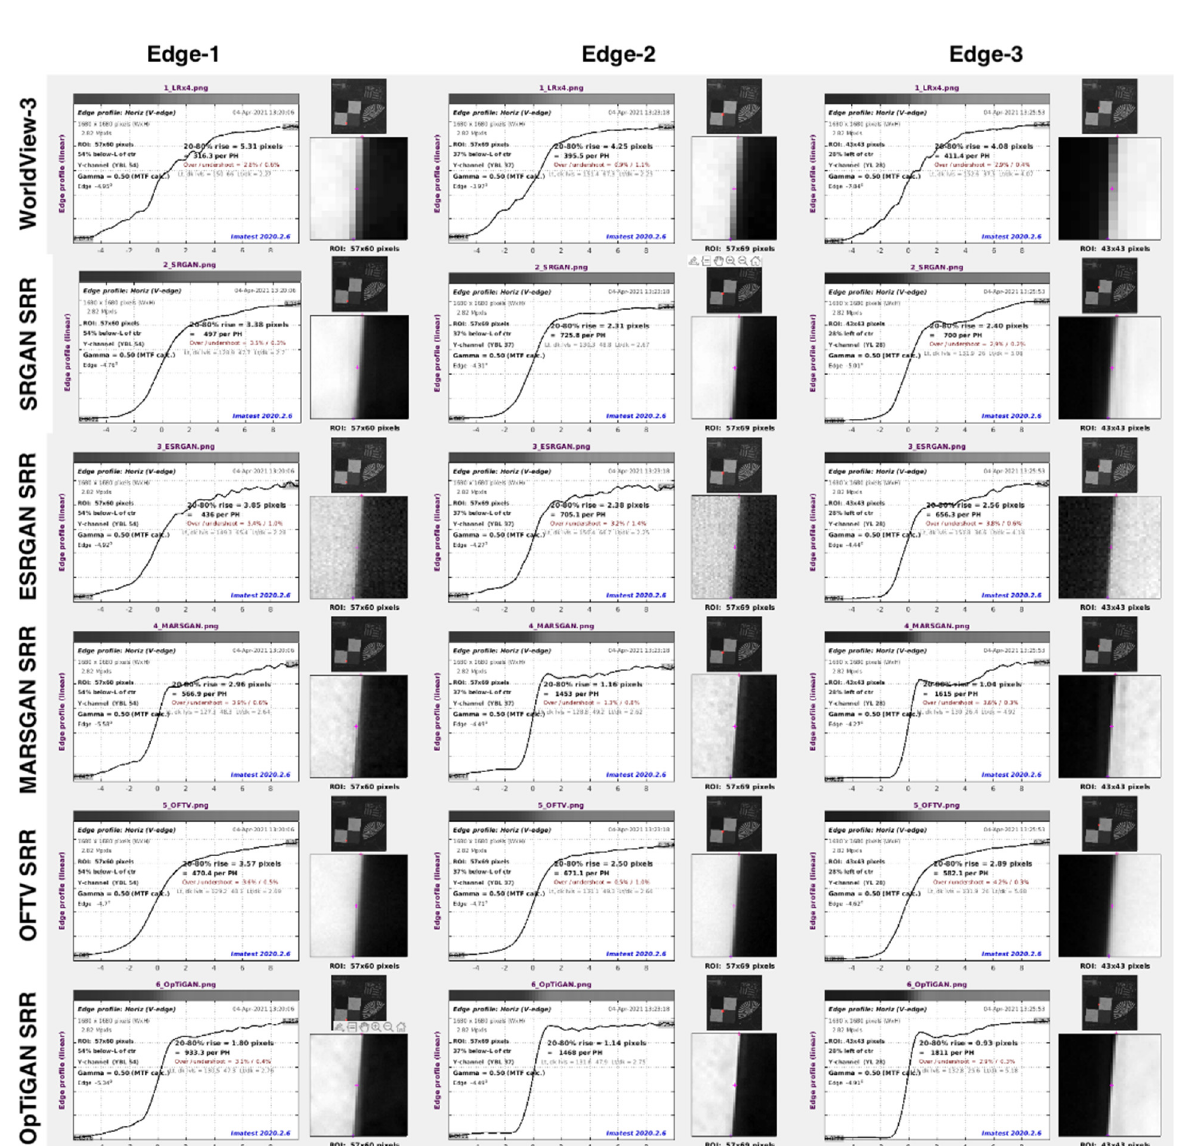
Figure 7. Imatest ® slanted-edge profile measurements for the knife-edge target at the Baotou Geocal site, showing 3 automatically detected edges for each of the input WorldView-3 image (upscaled by a factor of 4 for comparison), SRGAN SRR result, ESRGAN SRR result, MARSGAN SRR result, OFTV SRR result and OpTiGAN SRR result. For each slanted edge measurement, there is a plot, showing a profile line crossing the detected edge. Imatest ® measured the total pixel count of a 20–80% profile rise. For texts inside the plots, please refer to the original full-resolution figure in Supplementary Materials. WorldView-3 image courtesy of Maxar 2020. Data provided by the European Space Agency.